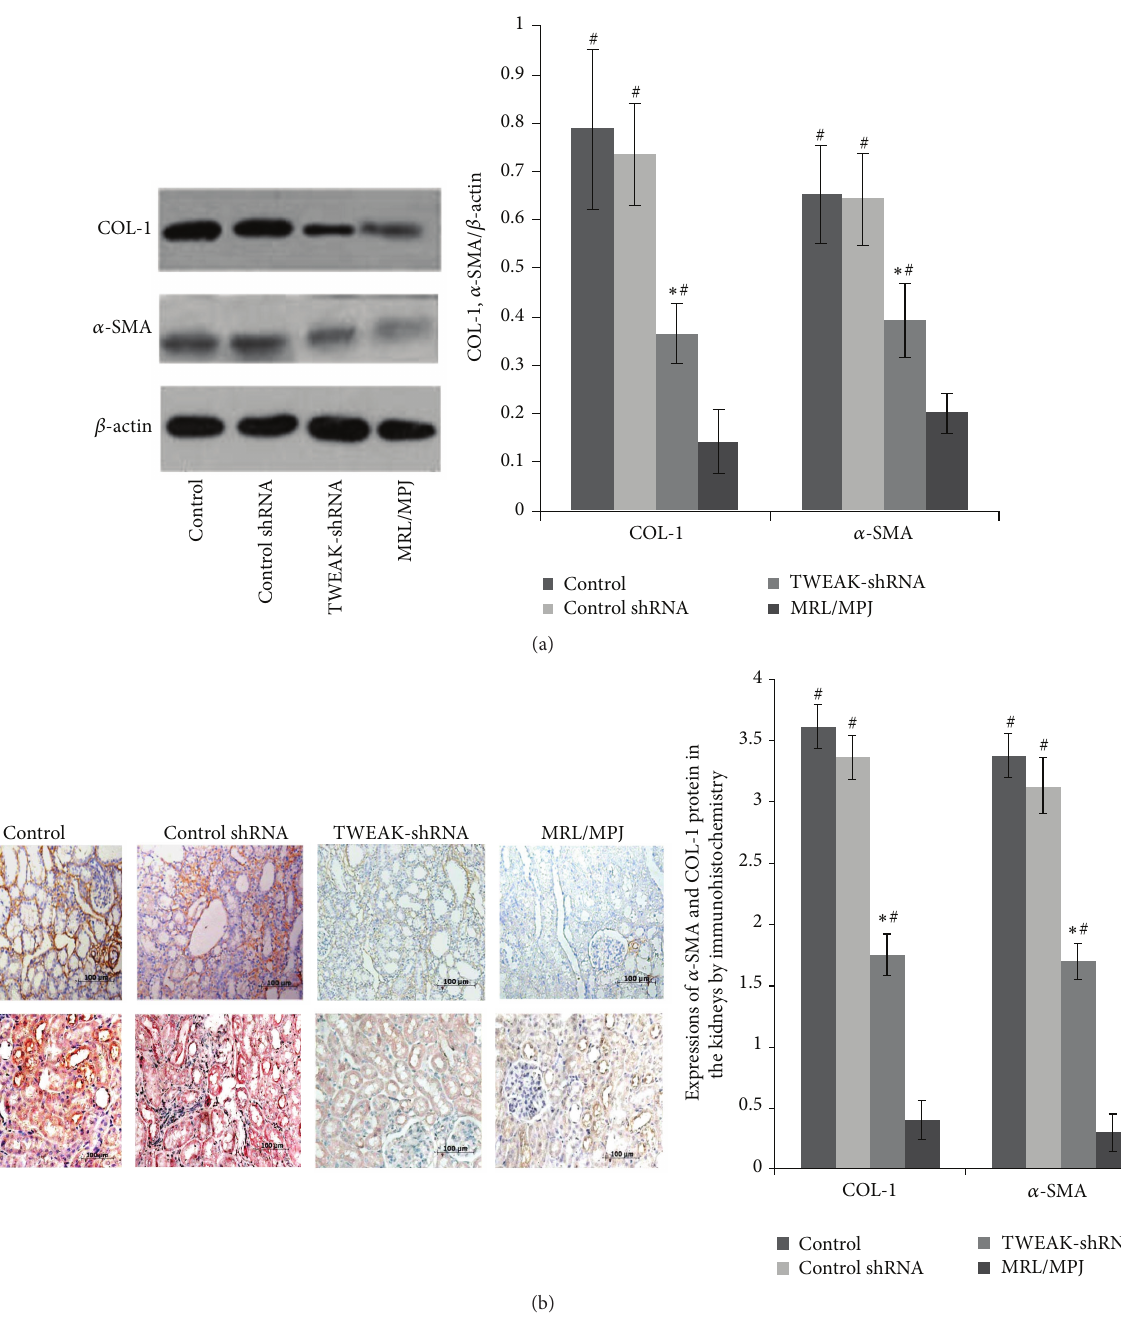
Figure 4: Effects of LV-TWEAK-shRNA treatment on expressions of 𝛼 -SMA and COL-1 proteins in kidneys of MRL/lpr mice. (a) Total lysates of kidneys were collected for Western blotting to measure COL-1 and 𝛼 -SMA protein expressions. The representative experiment was presented(left).TheratiosofCOL-1/ 𝛽 -actinIODand 𝛼 -SMA/ 𝛽 -actinIODwereshown(right).(b)Distributionof 𝛼 -SMAandCOL-1proteins in the kidney was tested by immunohistochemistry. The histologic scores of 𝛼 -SMA and COL-1 proteins were shown at the bottom. Control: MRL/lpr mice treated with PBS; Control shRNA: MRL/lpr mice treated with LV-Control shRNA; TWEAK-shRNA: MRL/lpr mice treated with LV-TWEAK-shRNA; and MRL/MPJ: MRL/MPJ mice as normal control. The error bars represent the standard deviation. # 𝑝 < 0.01 versus MRL/MPJ mice and ∗ 𝑝 < 0.01 versus control MRL/lpr mice. Scale bar: 100 𝜇